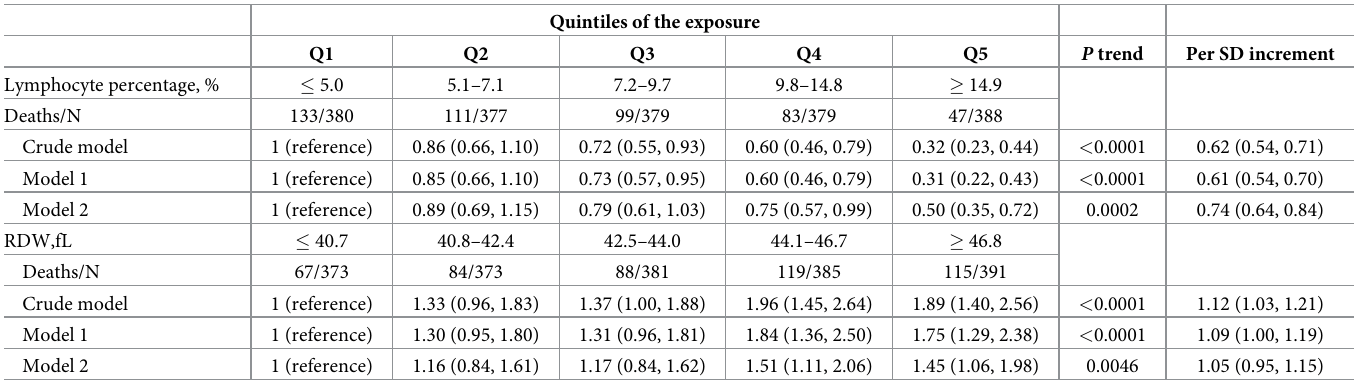
Table 2. Associations of lymphocyte percentage and RDW level with risk of in-hospital mortality.